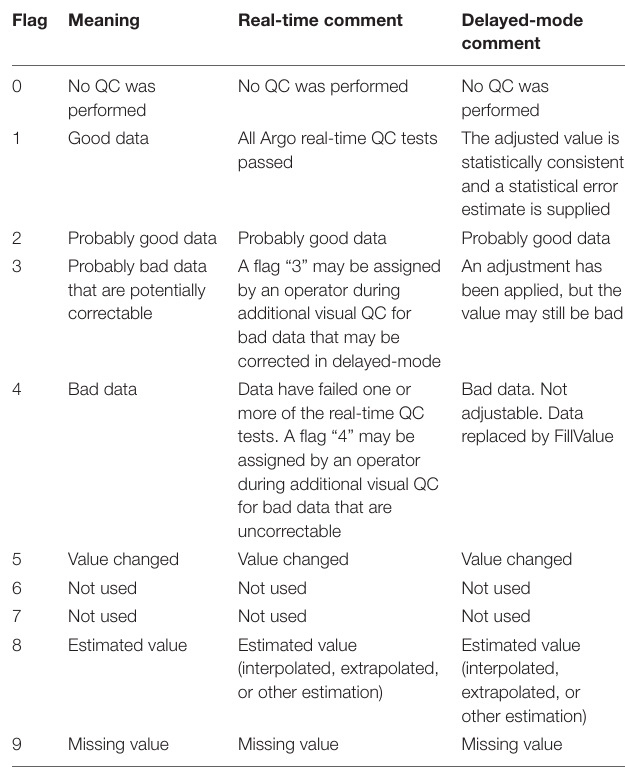
TABLE 7 | “Argo reference table 2” with meanings of quality control flags from the Argo QC manual (Wong et al., 2019). Flag